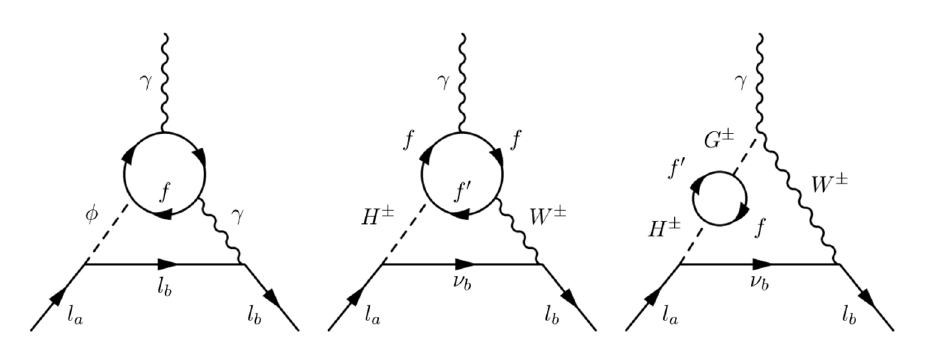
Figure 6 . Two-loop fermionic Barr-Zee diagrams contributing to muon g − 2 and l → l 0 γ . The indices a, b correspond to any of the lepton flavours e, µ, τ , and φ = h, H, A . The internal photon γ may be replaced by a Z